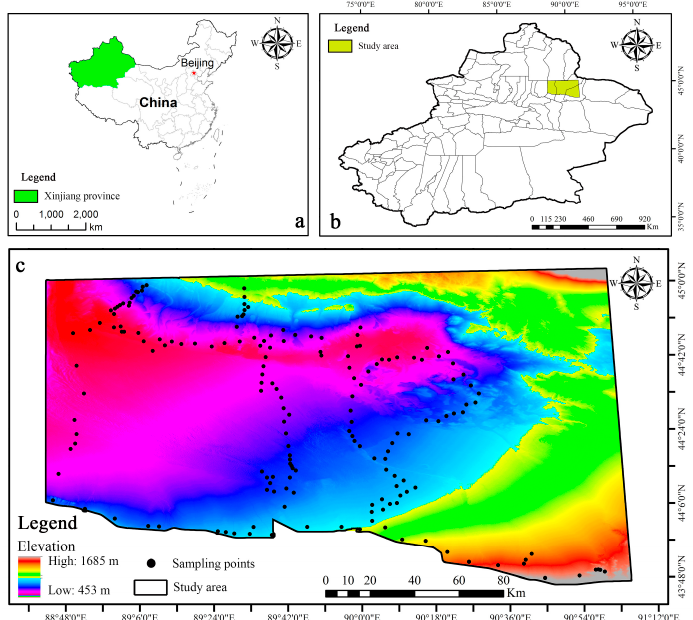
Figure 1. Geographical location of Xinjiang Province ( a ) and study area ( b ), and spatial distribution of sampling points ( c ).